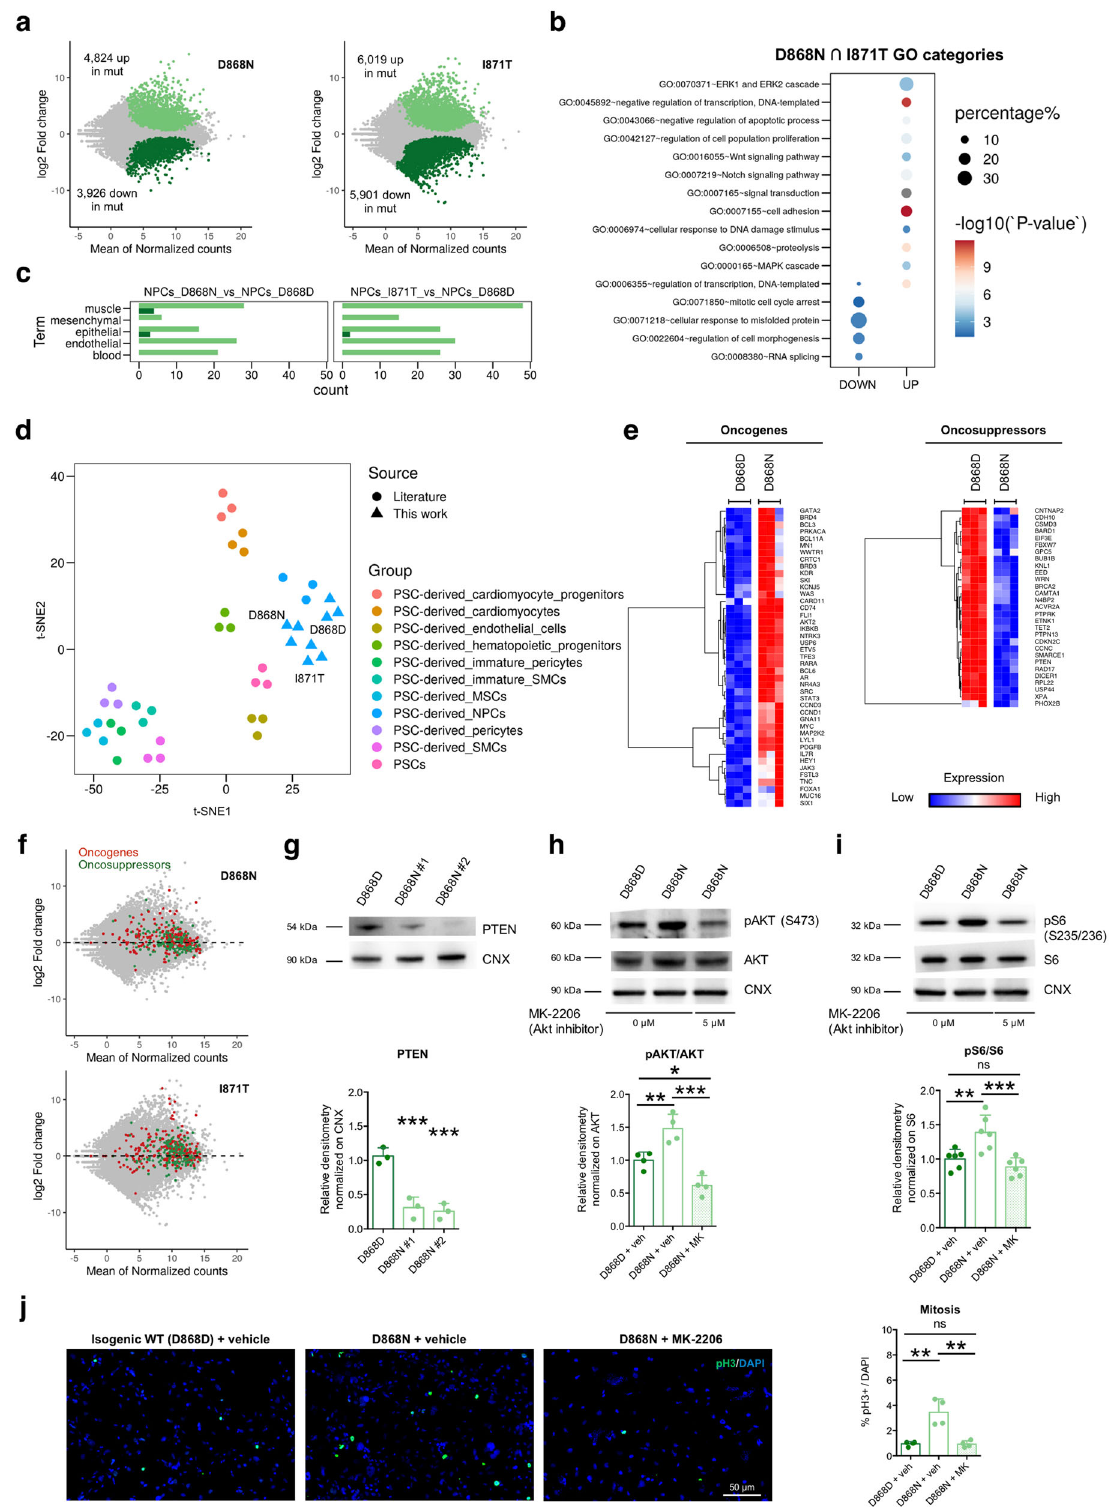
multicellular composition. Thus, starting from control and SGS iPSCs we generated both cerebral organoids 34 (Fig. 6a) and cor- tical spheroids 35 (Supplementary Fig. 9a). SGS cerebral organoids presented SETBP1 and SET protein accumulation which did not correlate with PP2A activity inhibition, as observed in 2D NPC cultures (Fig. 6b). At the morphological level, mutant organoids grew in a more elaborated